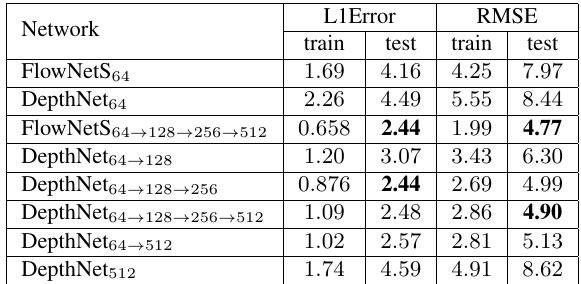
Table 3. quantitative results for depth inference networks. FlowNetS is modified with 1 channel outputs (instead of 2 for inferring flow), and trained from scratch for depth with Still Box. Subscript indicates fine tuning process.